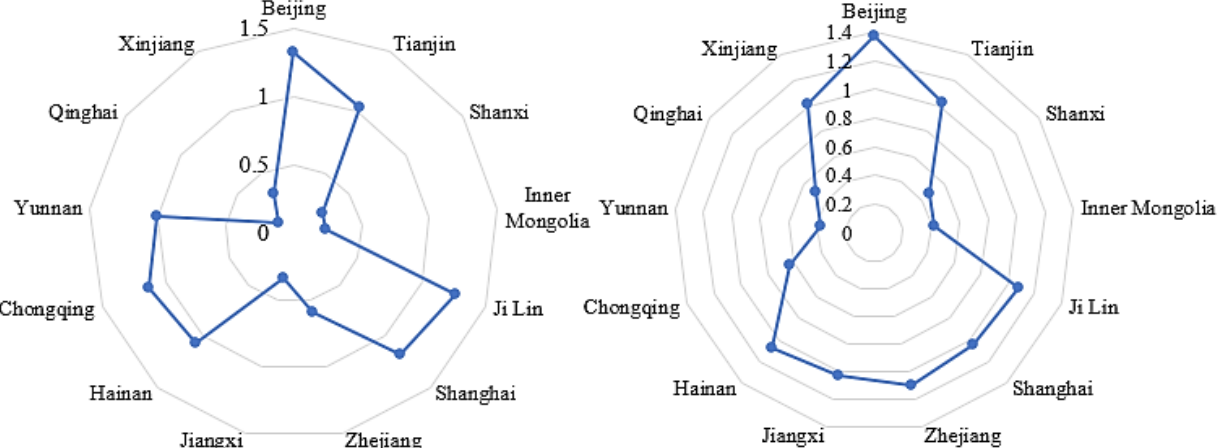
Figure 2. The trends of GIE levels during 2010 – 2019.